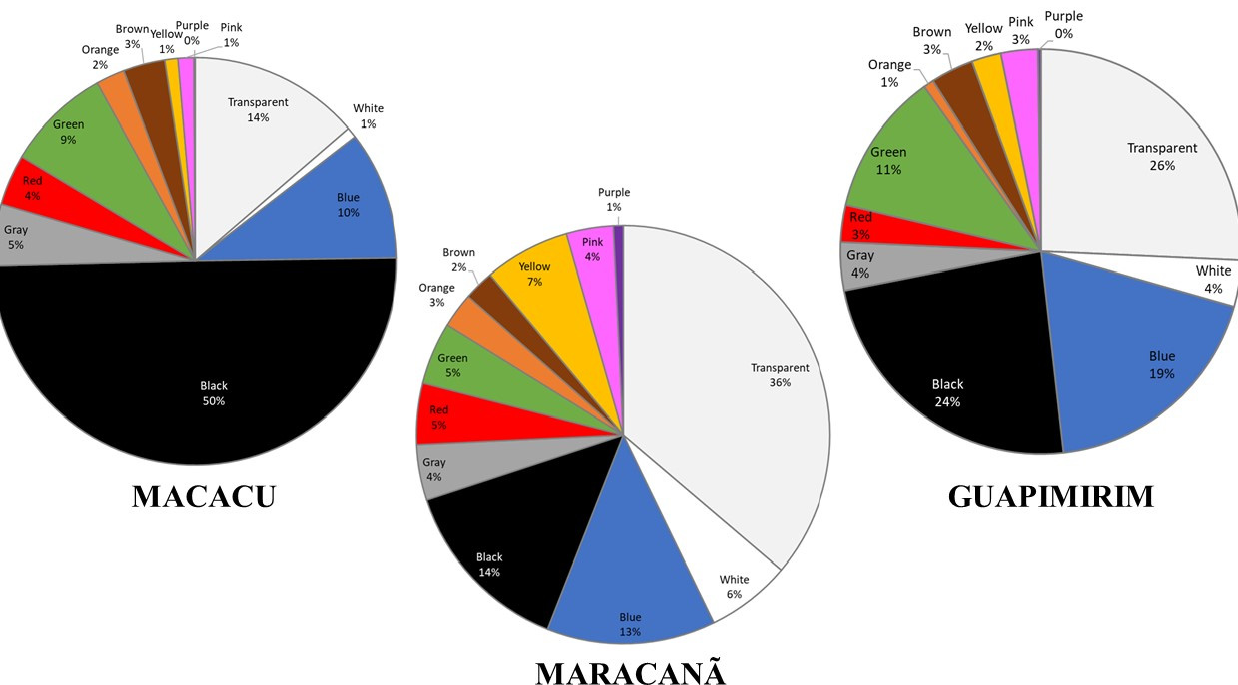
Figure 3. Microplastic color abundance in the water of the three studied rivers.